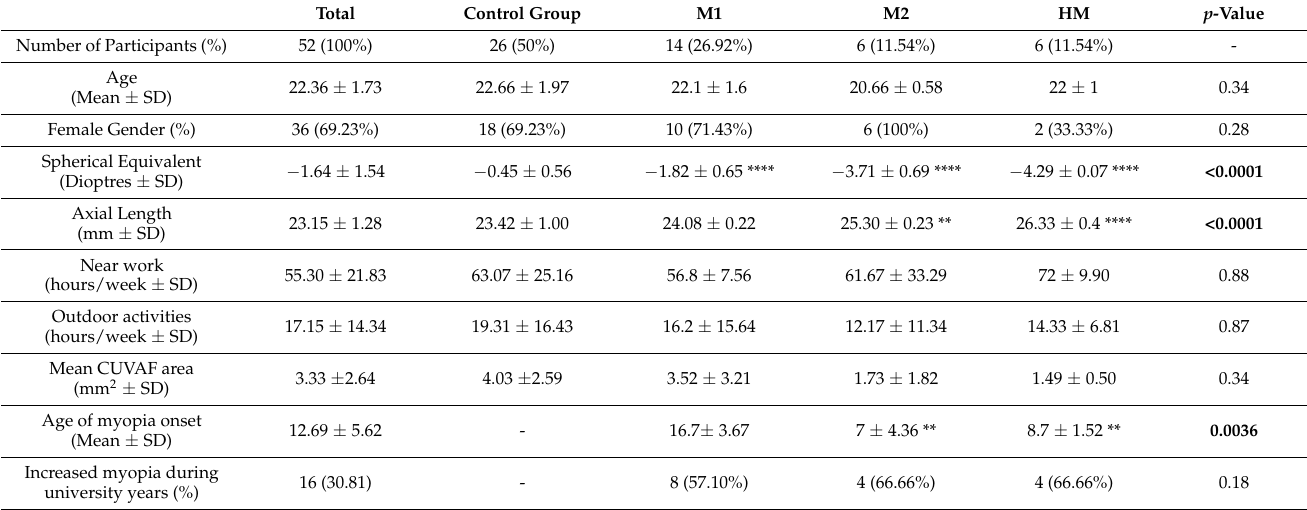
Table 2. Demographic and ophthalmological characteristics of environmental science